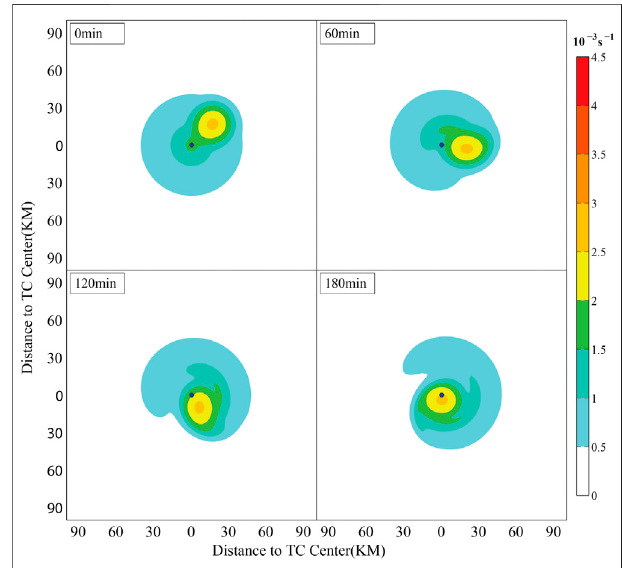
FIGURE8| Evolutionofvorticityproducedbynondivergencebarotropic model within 3 h (corresponding with 1:00 to 4:00 UTC in Figure 6 ).